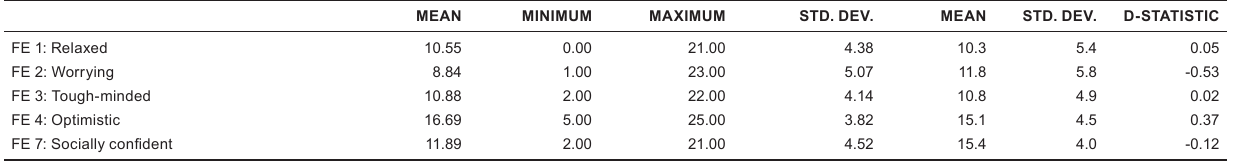
TABLE 3 Descriptive statistics of the stress management obtained (n = 105) in comparison with the managerial and professional norm group (n = 329) MEAN MINIMuM MAxIMuM STD. DEv. STD. DEv. D-STATISTIC